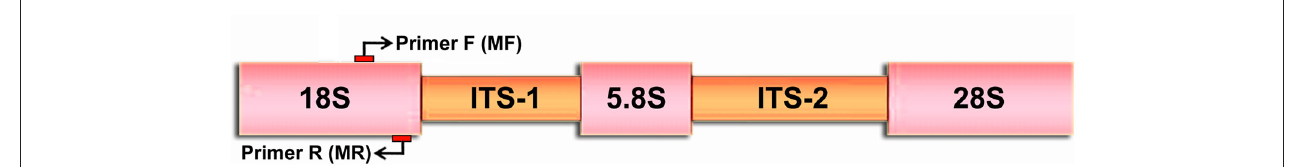
FIGURE 1 | Schematic diagram of rDNA showing Forward (MF) and Reverse primer (MR) annealing positions. The arrows show the annealing position for primers in the 18S ribosomal subunit.